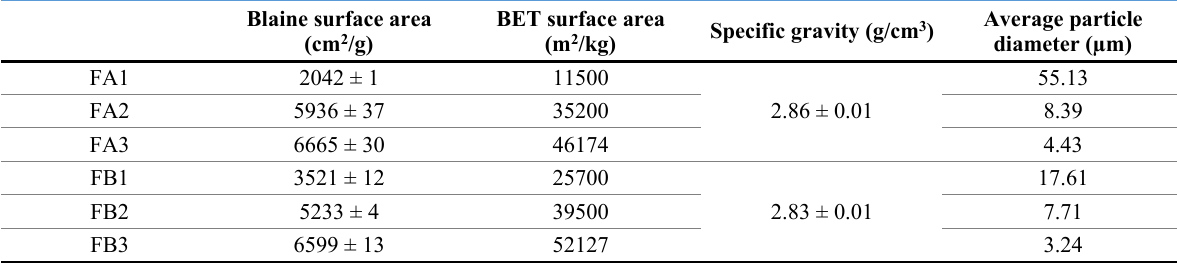
Table 2. Physical characterization of the fines used